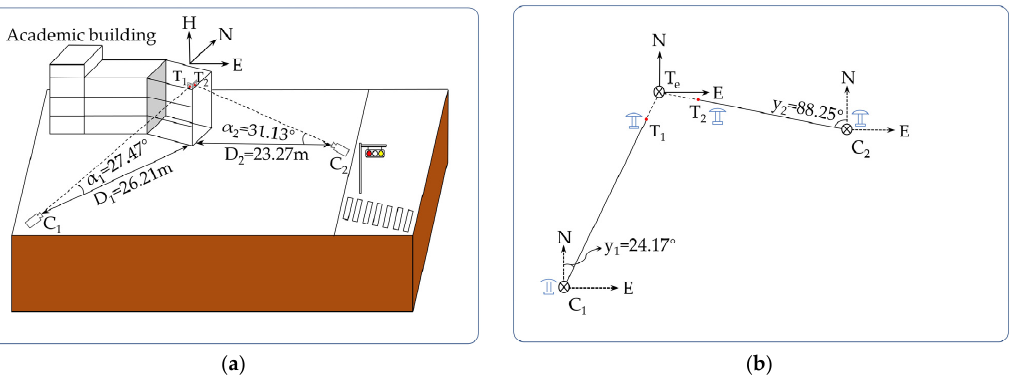
Figure 11. Schematic of camera-target point arrangement: ( a ) spatial relations; ( b ) top view. Table 2. Positions and distances between the cameras and the corresponding target